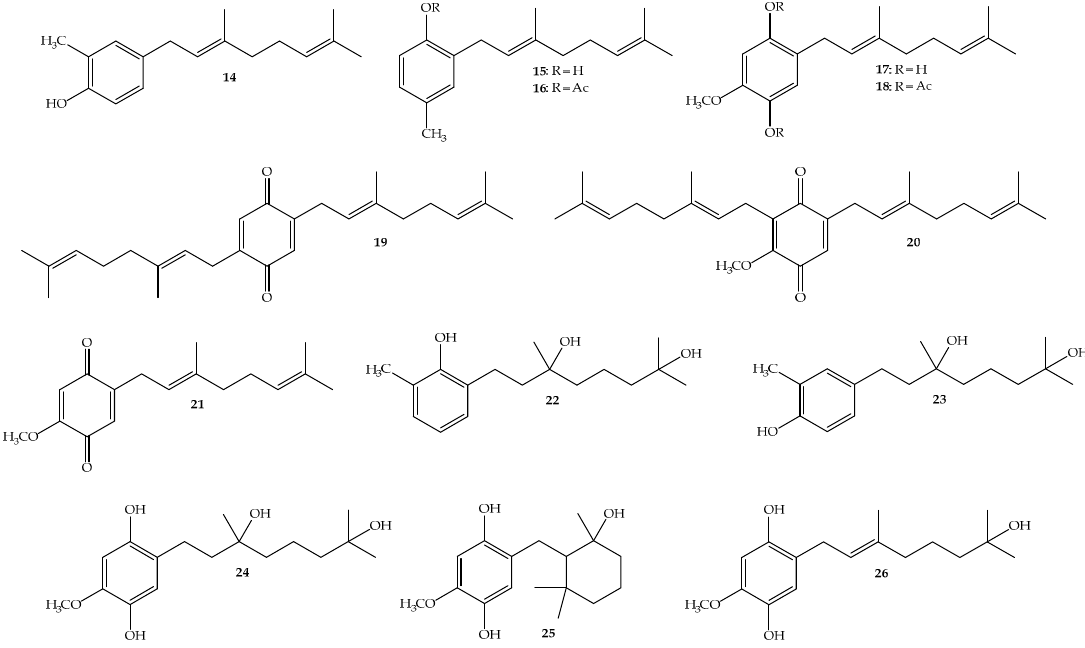
Figure 2. Chemical structures of geranylated phenols ( 14 – 18 ) geranylated quinones ( 19 – 21 ) and hydrated geranylphenols derivatives ( 22 – 26 ) that have been studied in this work.